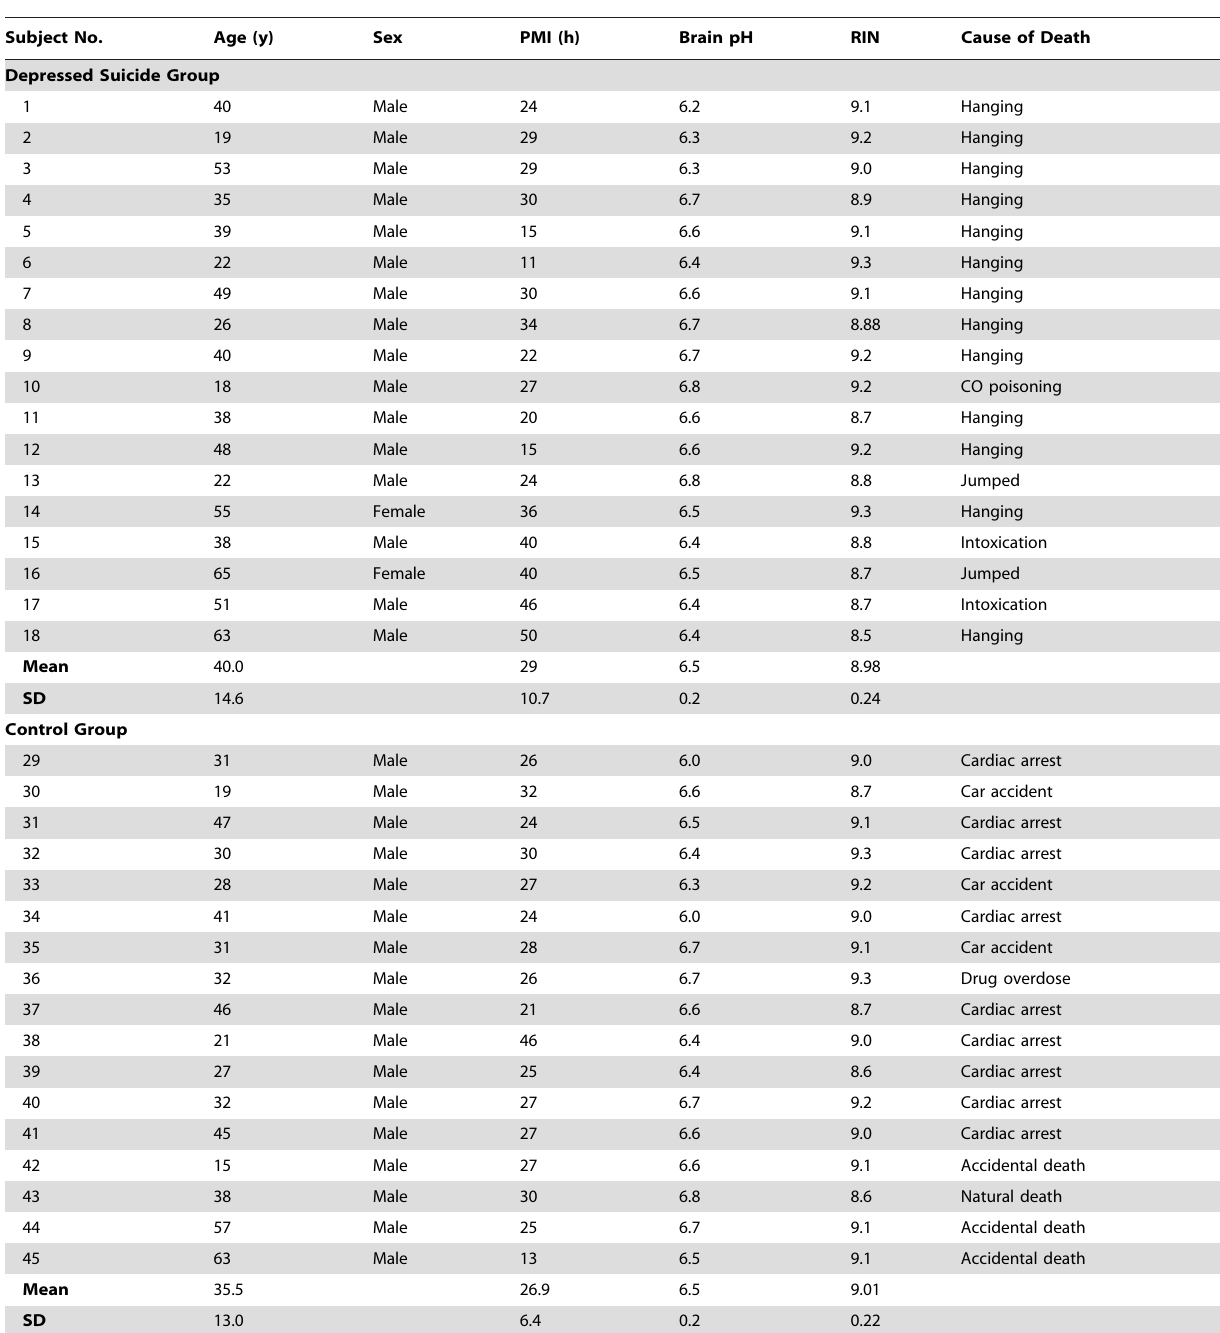
Table 1. Characteristics of subjects in the depressed suicide and normal control